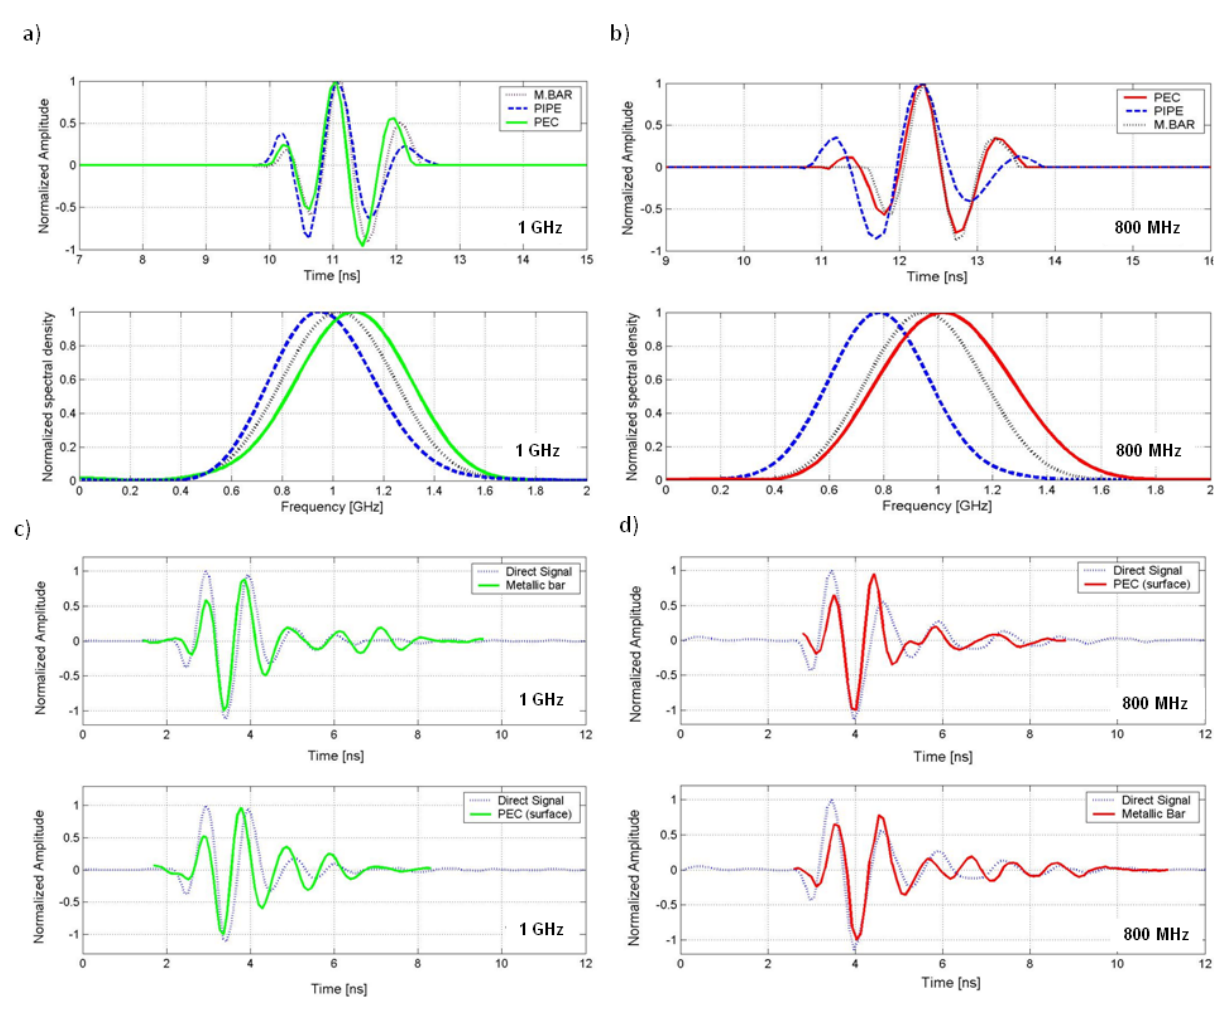
Figure 7 . (a-b) Time and spectral domain comparison between wavelets obtained using the different methodologies for the 1 GHz and 800 MHz antennas, respectively. (c-d) Similarity between the direct signal and the emitted wavelet for the 1000 and 800 MHz antennas, respectively. (Emitted wavelets were normalized and inverted in phase for comparison with the direct signal).